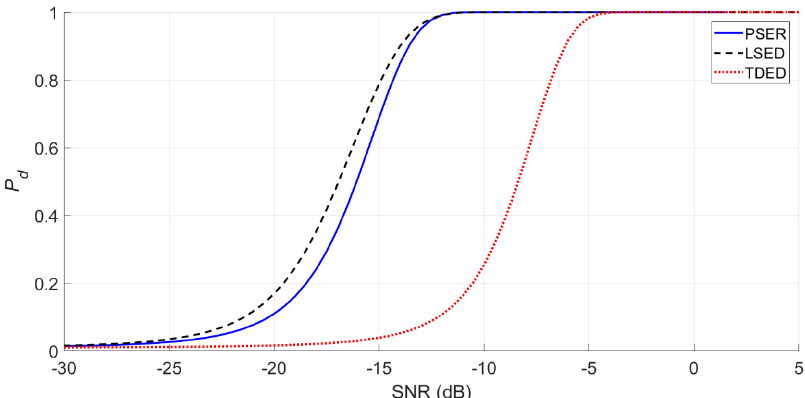
Figure 4. Detection probabilities of the three methods compared when the sub-band contains all the energy ( N = 512 ， d = 20 ， and P f = 0.01).